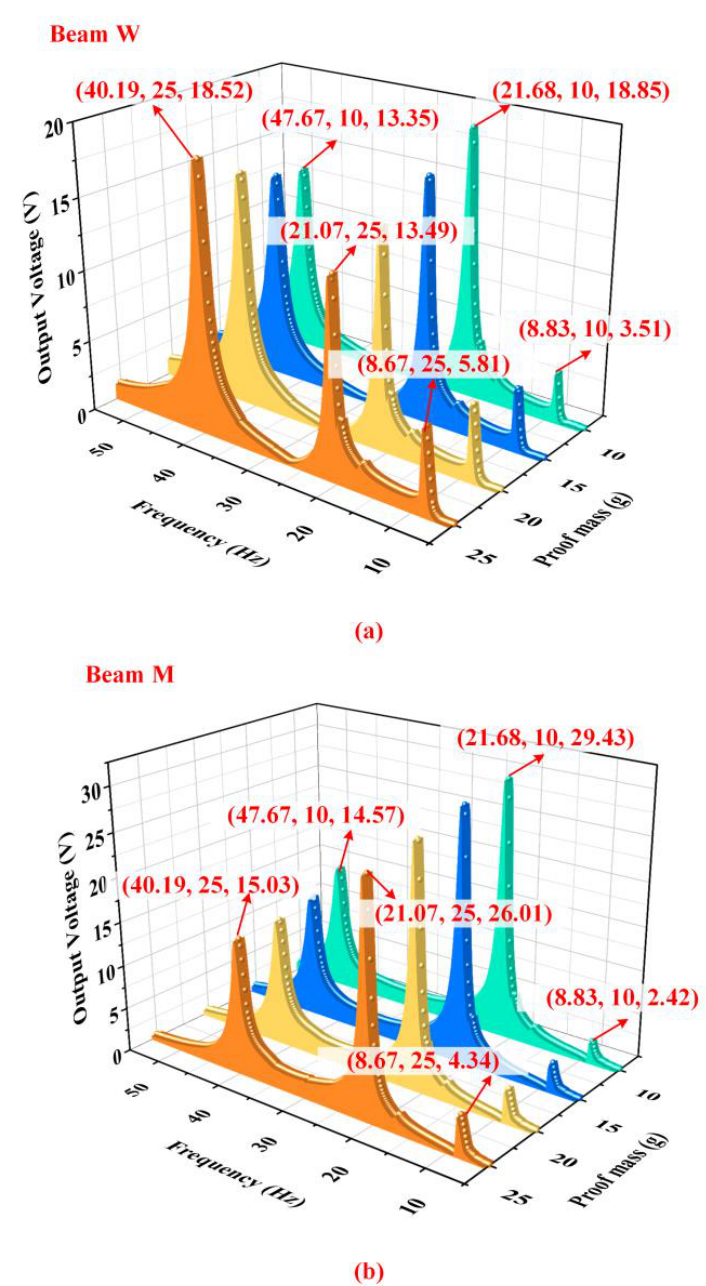
Figure 9. The output voltage of ( a ) beam W and ( b ) beam M with different weights of the proof mass by experiment.